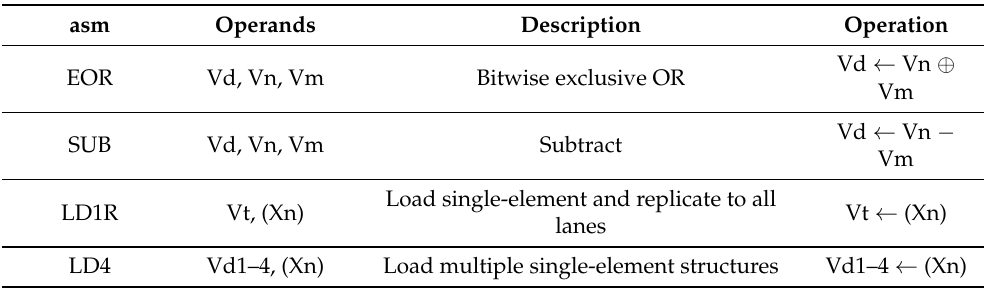
Table 1. Instruction set for optimized parallel implementation ARIA block cipher. Xd: destination scalar register, Xn: source scalar register, Vd: destination vector register, Vt: transferred vector